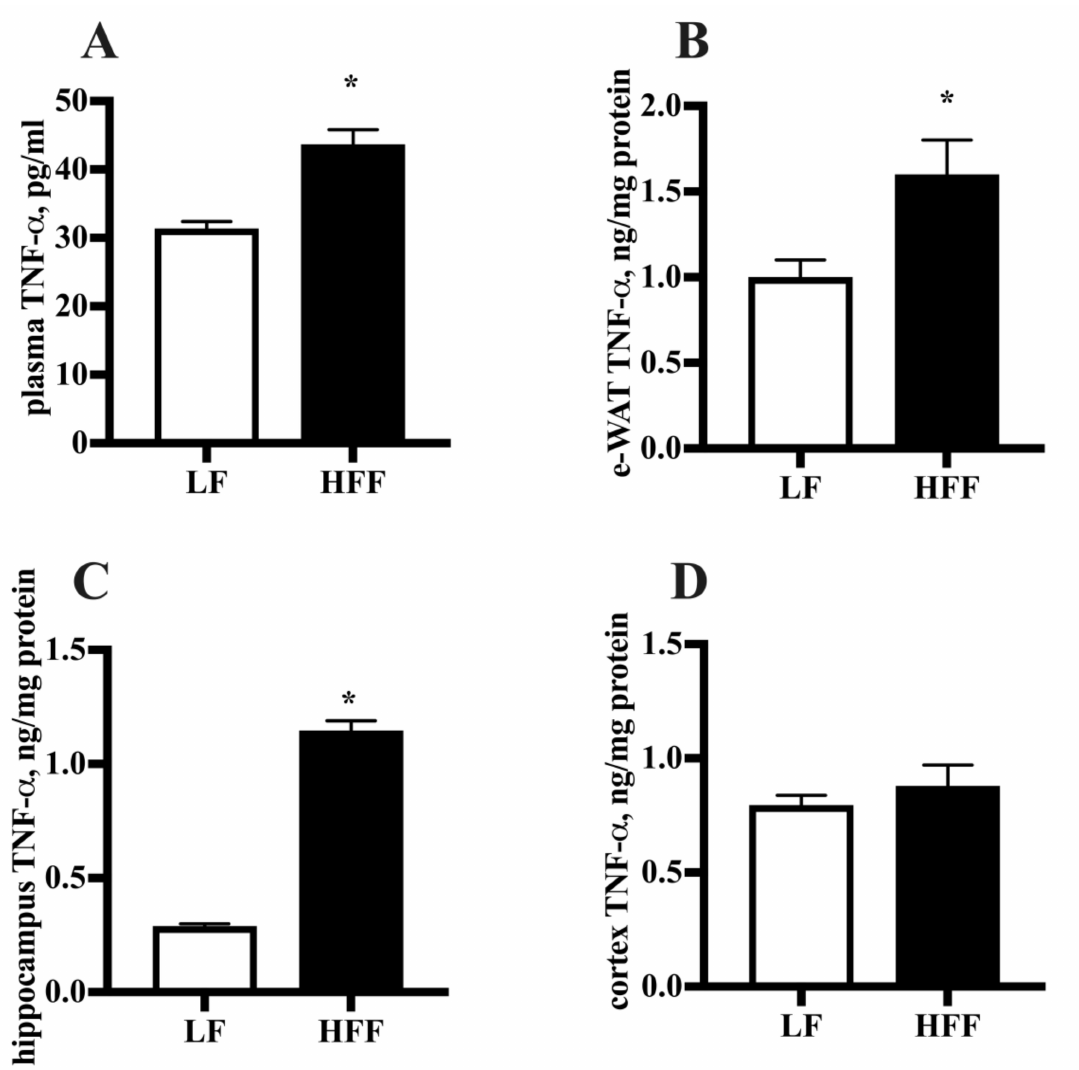
Figure 3. Levels of tumor necrosis factor alpha (TNF- α ) detected by enzyme-linked immunosorbent assayin plasma ( A ), epididymal white adipose tissue (e-WAT) ( B ), hippocampus ( C ), and frontal cortex ( D ) from middle-aged rats fed low fat (LF) or high fat-high fructose (HFF) diets for four weeks. Values are the means ± SEM of eight rats. * p < 0.05 compared to low-fat diet (two-tailed Student’s